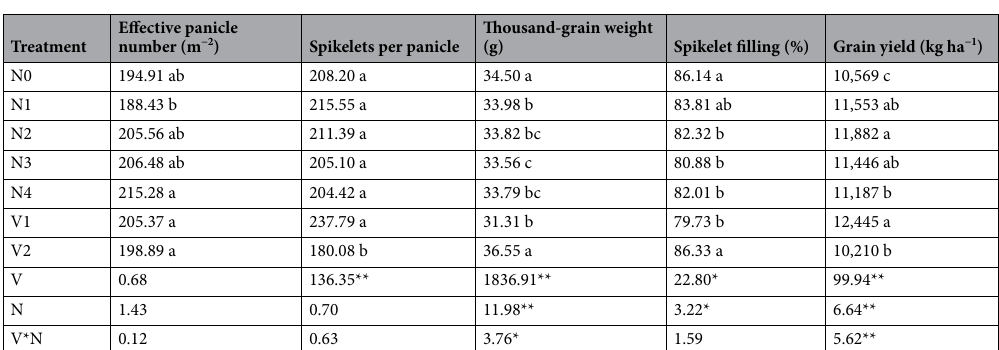
Table 1. Yield and its component under different treatments in rice. Note Significant differences between rice varieties and nitrogen treatments ( P < 0.05) are indicated by lowercase letters, and * and ** indicate significant effects ( P < 0.05) and extremely significant effects ( P < 0.01), respectively. The data in the table is the average value of the two cultivars. The same as below.